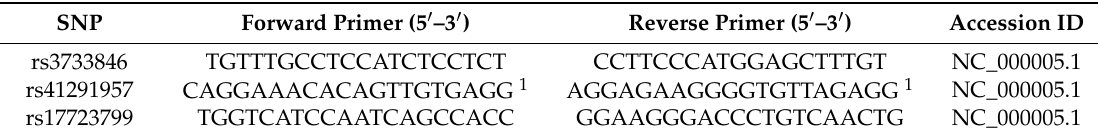
Table 2. Sanger sequencing primers for three analysed MIR143 single nucleotide polymorphisms. SNP Forward Primer (5 (cid:48) –3 (cid:48) ) Reverse Primer (5 (cid:48) –3 (cid:48)